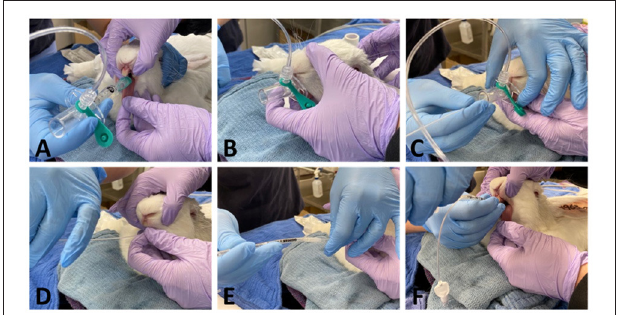
FIGURE 1 | Representative pictures showing ETI performed with method 1. A size R4 v-gel ® is inserted (A) and correct placement is verified by capnography (B) . A 3.5 Fr polypropylene guide catheter is then inserted through the v-gel ® airway channel (C) . The v-gel ® is then removed and a ETT is threaded over the guide, with the head of the rabbit kept in a neutral position, without extension of the neck (D-F) .